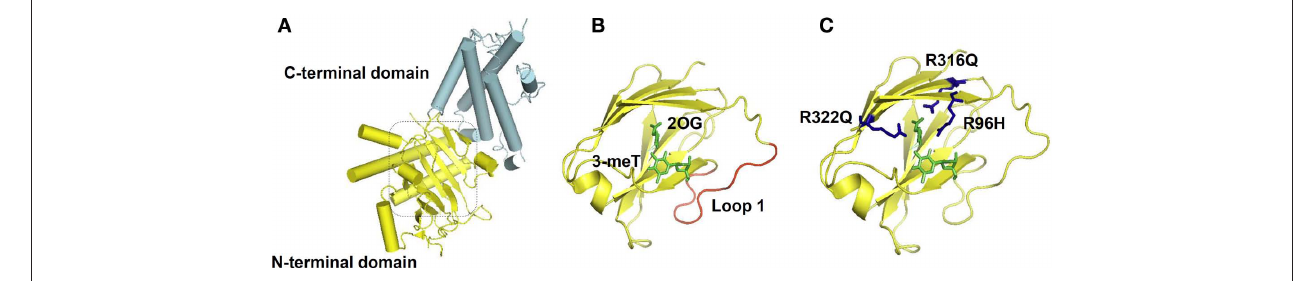
physically hinder the entrance of dsDNA/RNA is in red. (C) Residues that cause a compete loss-of-function of FTO: R316 and R322 that are required for 2-OG binding, and R96 that occurs in the substrate recognition lid, are shown in blue. The molecular graphics were generated using PyMOL (Version 1.1r1, Schrödinger,